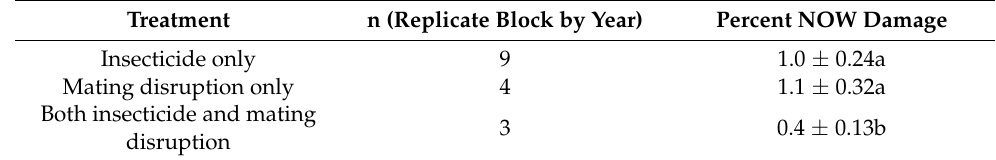
Table 4. Percent navel orangeworm damage (mean ± SE) from interior windrow samples, by insecticide, and mating disruption treatment and across all varieties, 2006 and